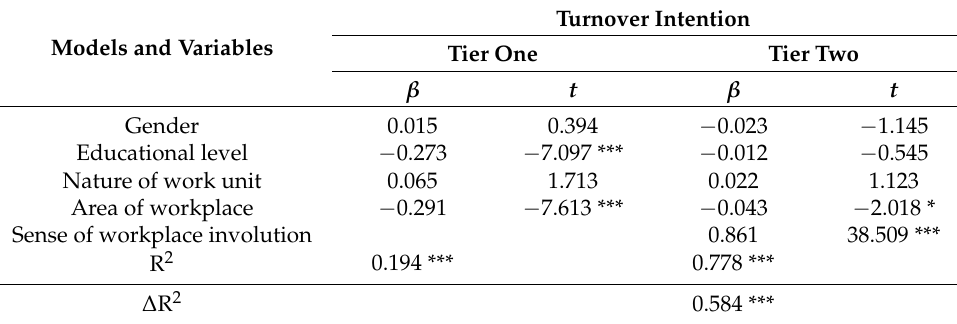
Table 9. Hierarchical regression results of turnover